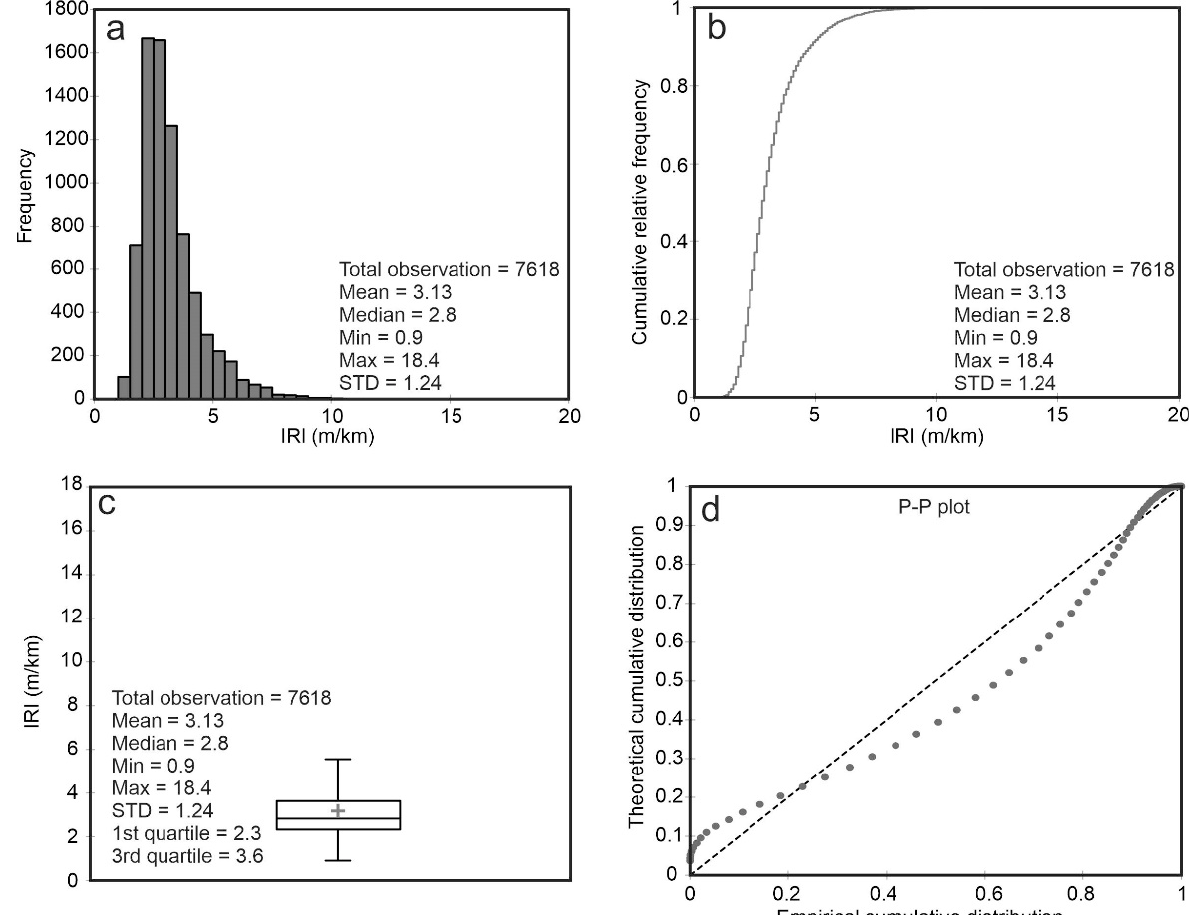
Figure 3. ( a ) Histogram of IRI measurements for the study area. ( b ) Empirical cumulative distribution of IRI measurements. ( c ) Boxplot of IRI measurements. The “+” sign indicates the mean IRI value. ( d ) Probability–probability (P-P) plot of the empirical cumulative distribution versus the theoretical cumulative distribution.